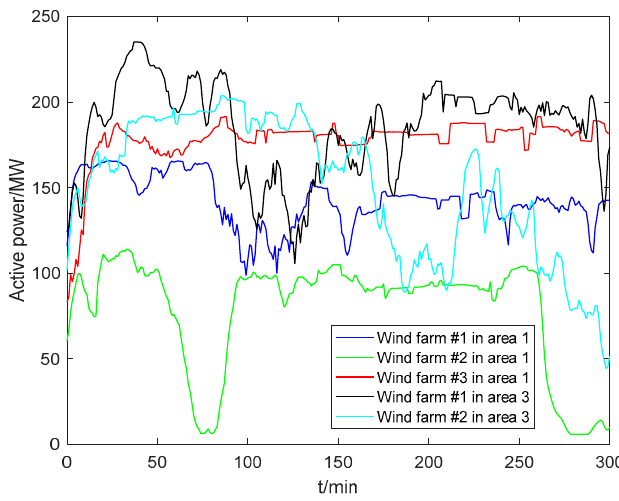
Figure 3. Wind farm prediction power sequence datasets.